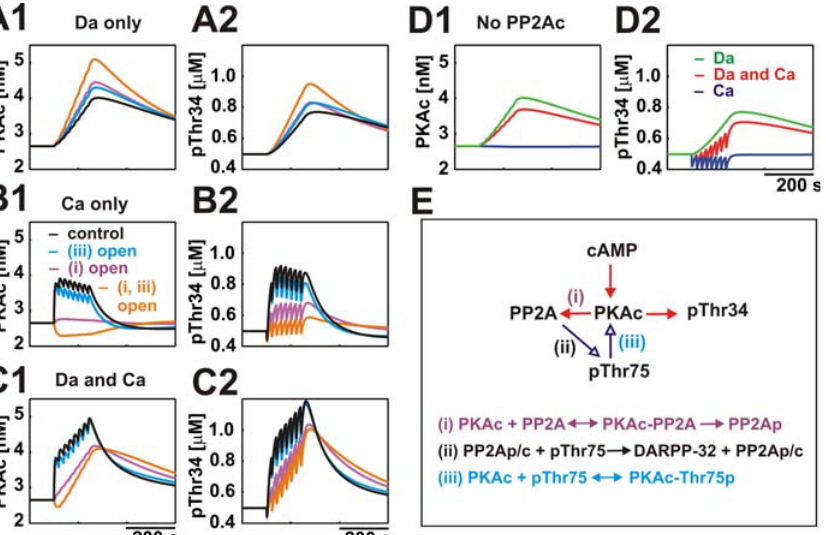
Figure 6. Role of the PKA–PP2A–phosphoThr75 Feedback Loop on PKAc and phosphoThr34 (A) Eight high-amplitude, brief, dopamine pulses, 20 s apart, lead to a larger buildup of free PKAc (A1) or Thr34 (A2) compared with control (black) if the reaction rates are set to zero in the PKA phosphorylation of PP2A only (purple; reaction (i) in (E) opened), in the phosphoThr75 inhibition of PKA only (light blue; reaction (iii) in (E) opened), or in both reactions (orange). Thus, both reactions (i) and (iii) in the PKA–PP2A–phosphoThr75 loop work as a sink for the PKAc signal. (B) High-amplitude, fast calcium inputs lead to a decreased level of free PKAc (B1) and Thr34 (B2) if reactions (i) and (iii) are prevented. Here the PKA– PP2A–phosphoThr75 loop behaves as a positive feedback loop on the PKAc concentration. (C) Paired fast calcium and dopamine elevations enhance PKAc (C1) and phosphoThr34 levels (C2) when the PKA–PP2A–phosphoThr75 loop is present (black lines), but decrease PKAc and phosphoThr34 when reactions (i) and (iii) are eliminated (orange lines). (D) Activation of PP2Ac by binding to calcium is required for the stimulatory effect of calcium on PKAc and phosphoThr34. Binding of calcium to PP2A shifts equilibrium of reaction (i) to the substrates, thus PKAc dissociates from PP2A, and shifts the equilibrium of reaction (iii) to the substrates, thus PKAc dissociates from phosphoThr75. If calcium activation of PP2A is prevented, dopamine alone (green lines) results in more PKAc (D1) and phosphoThr34 (D2) than paired calcium and dopamine (red lines). Also, calcium alone (blue lines) produces no significant response in PKAc and even causes a decrease in phosphoThr34. DOI: